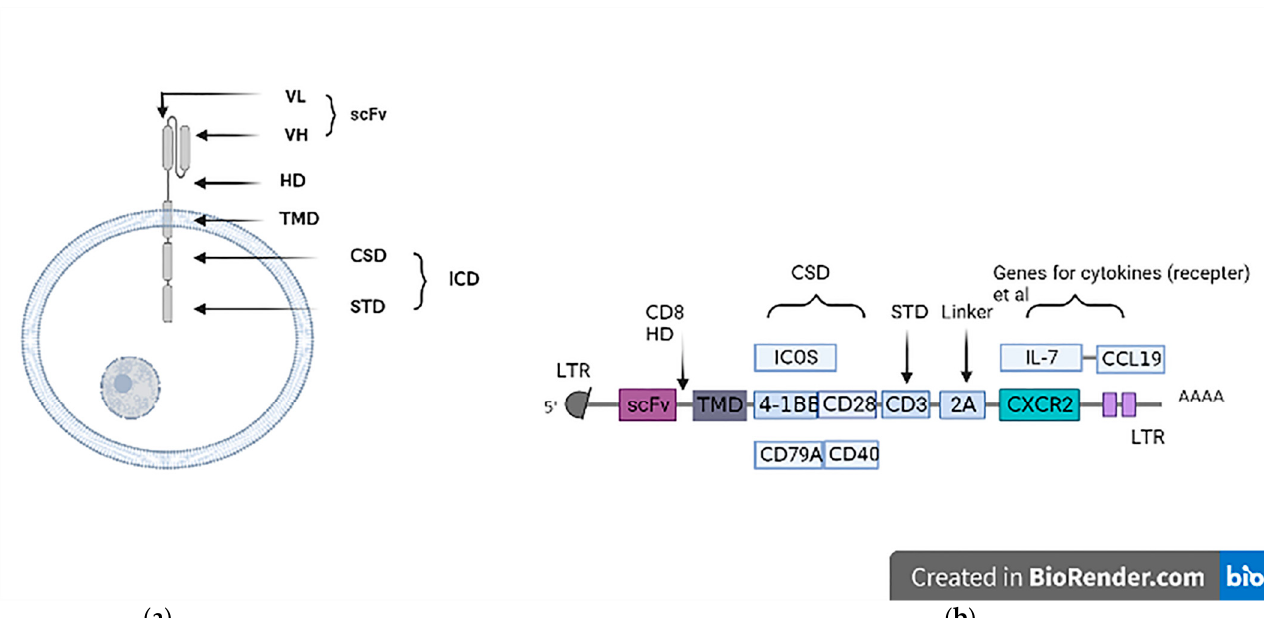
Figure 1. ( a ) Structure of CAR-T cells; ( b ) schematic of the transgene of a third-generation CAR. Long terminal repeat-retrotransposons (LTR), extracellular domain (ECD), transmembrane domain (TMD), intracellular domain (ICD), hinge domain (HD), costimulatory domain (CSD), variable domain of heavy chain (VH), variable domain of light chain (VL), signal transduction domain (STD), and single-chain variable fragments (scFv).